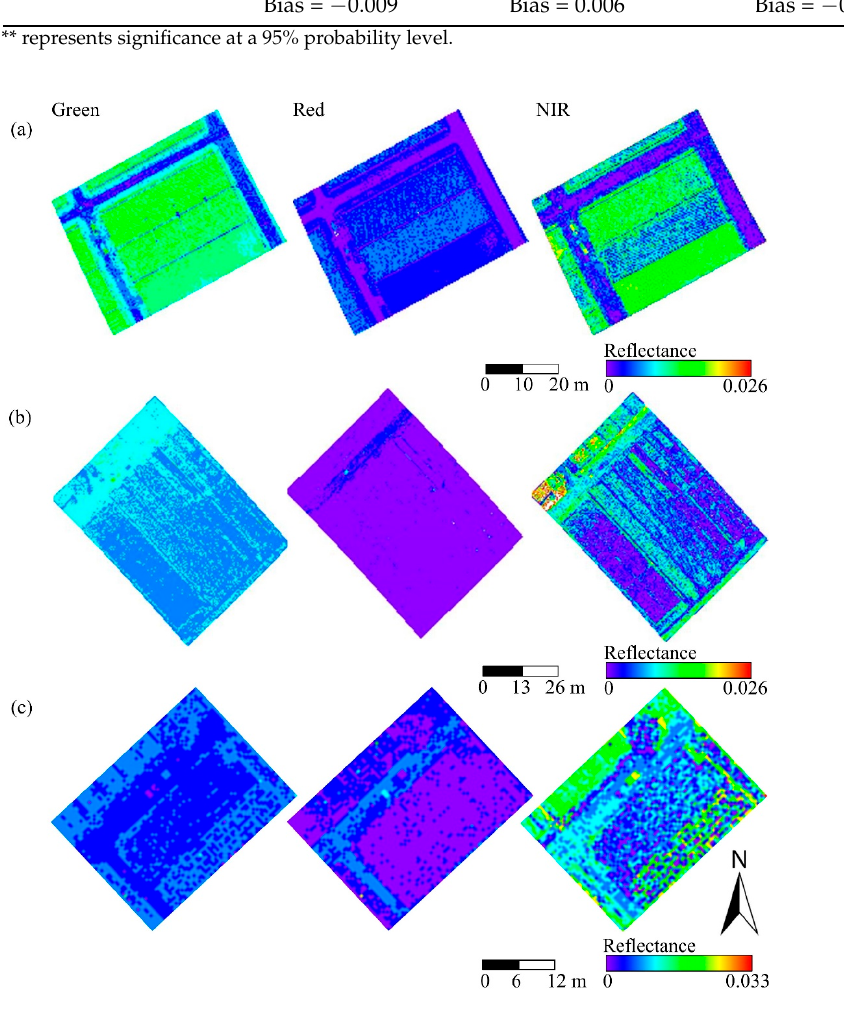
Figure 9. Deviation field map images between estimated and corrected reflectances for green (560 nm), red (660 nm), and NIR (830 nm) under different light intensities of ( a ) 1179 μ mol at the National Institute of Crop Science (NICS) and ( b ) 1100 μ mol and ( c ) 1230 μ mol at Chonnam National University (CNU).